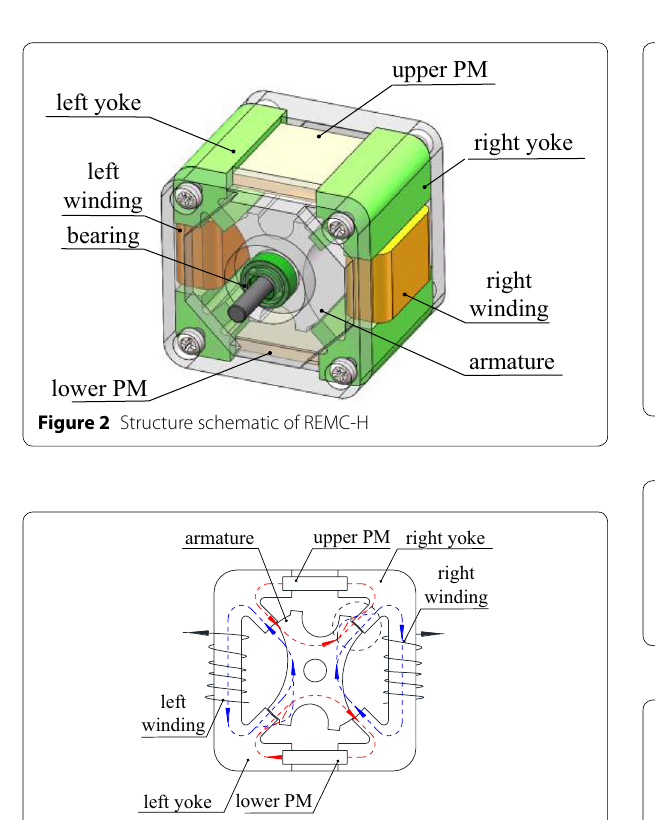
Figure 3 Magnetic circuit topology of REMC-H